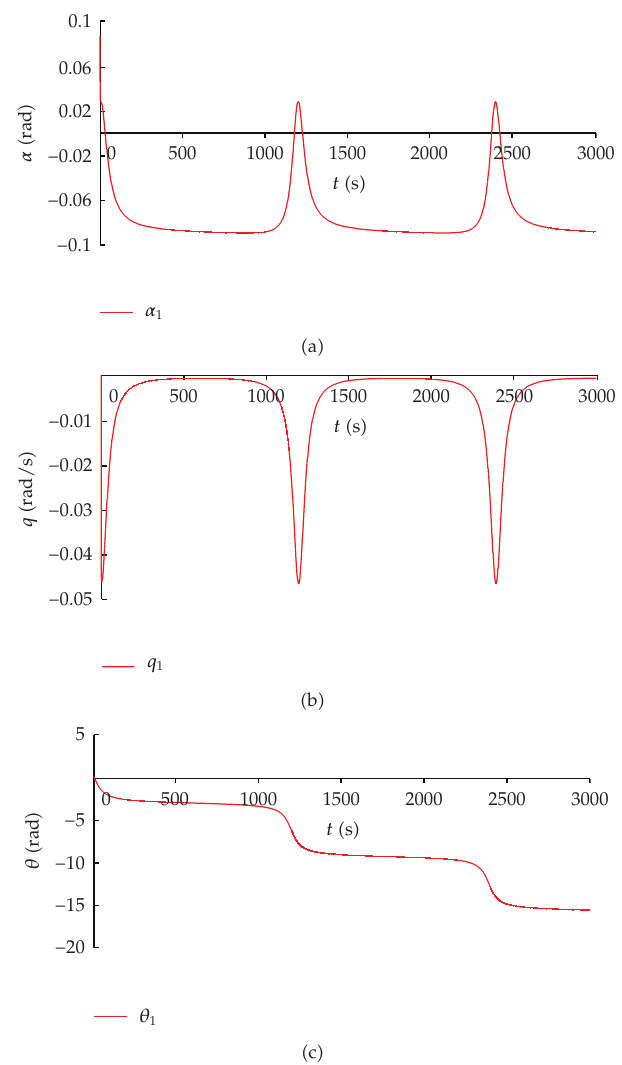
(cid:7) − 0 . 04678 (cid:5) rad (cid:6) (cid:7) − 2 . 681 ◦ → δ (cid:6)(cid:6) (cid:7) − 0 . 05 (cid:5) rad (cid:6) (cid:7) − 2 . 866 ◦ and the starting e e (cid:7) 0 (cid:5) rad / sec (cid:6) ; θ (cid:6) (cid:7) 0 . 1593297 (cid:5) rad (cid:6) (cid:7) 9 . 133 ◦ 1 1